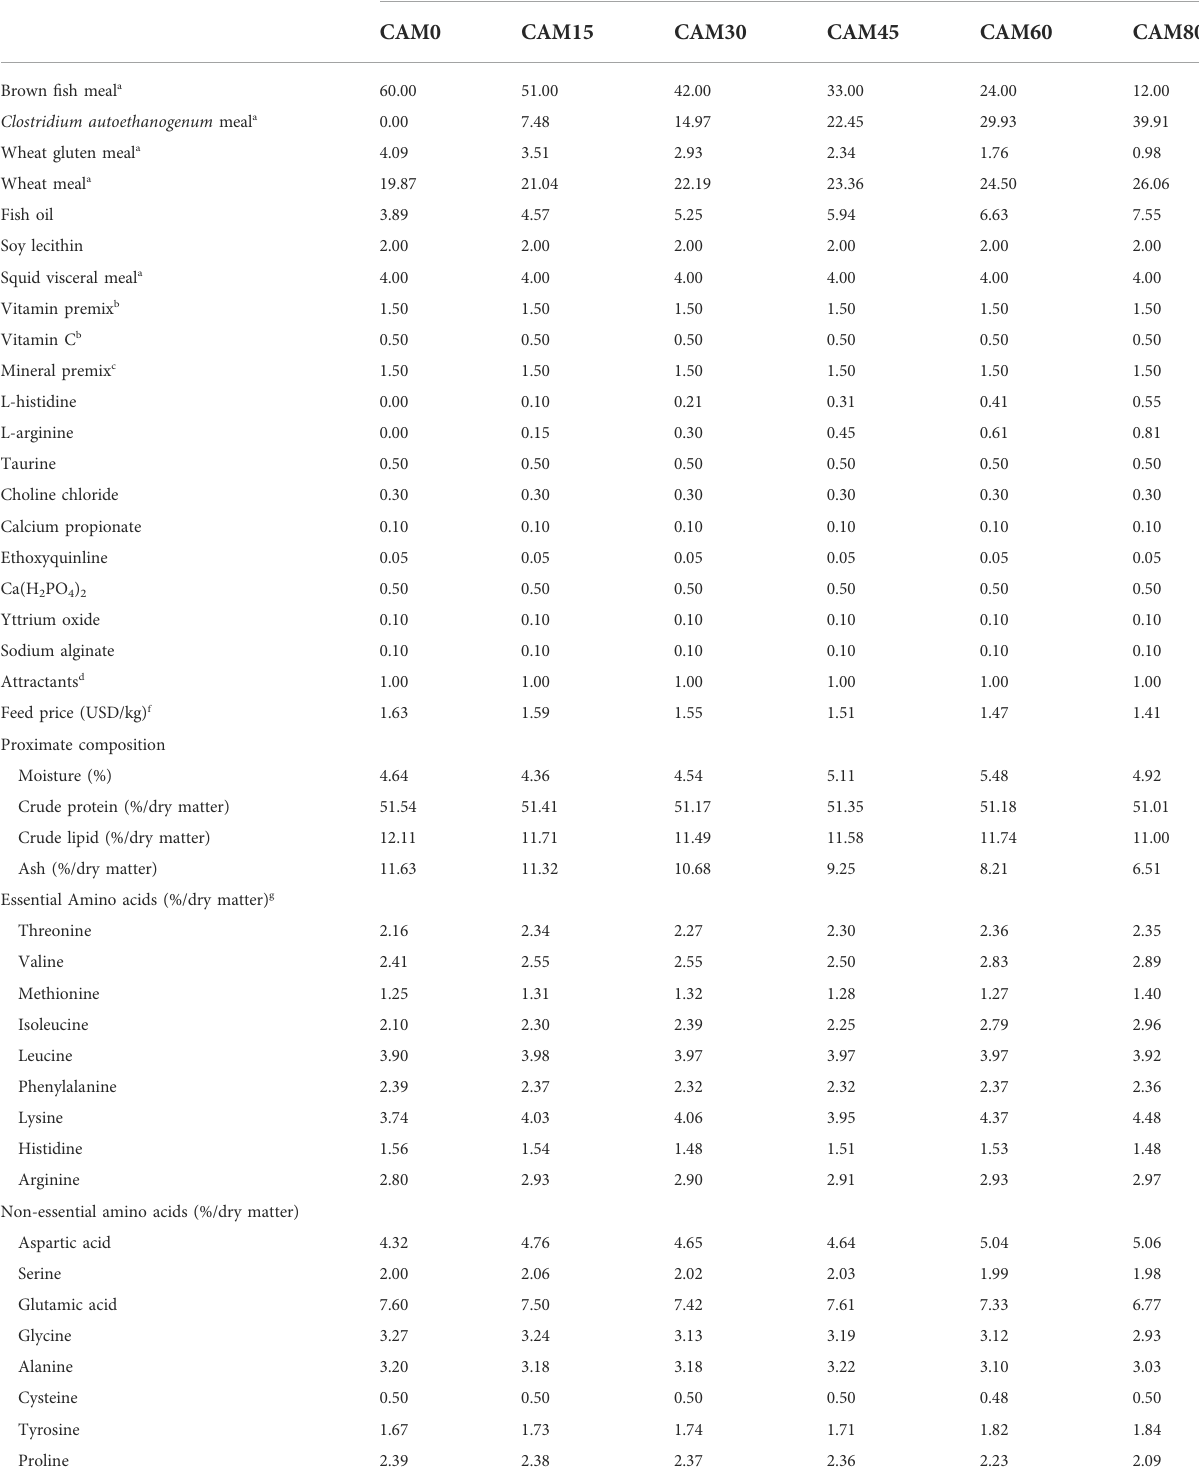
TABLE 1 Formulation, proximate composition and amino acids pro fi le of experimental diets (% dry matter).